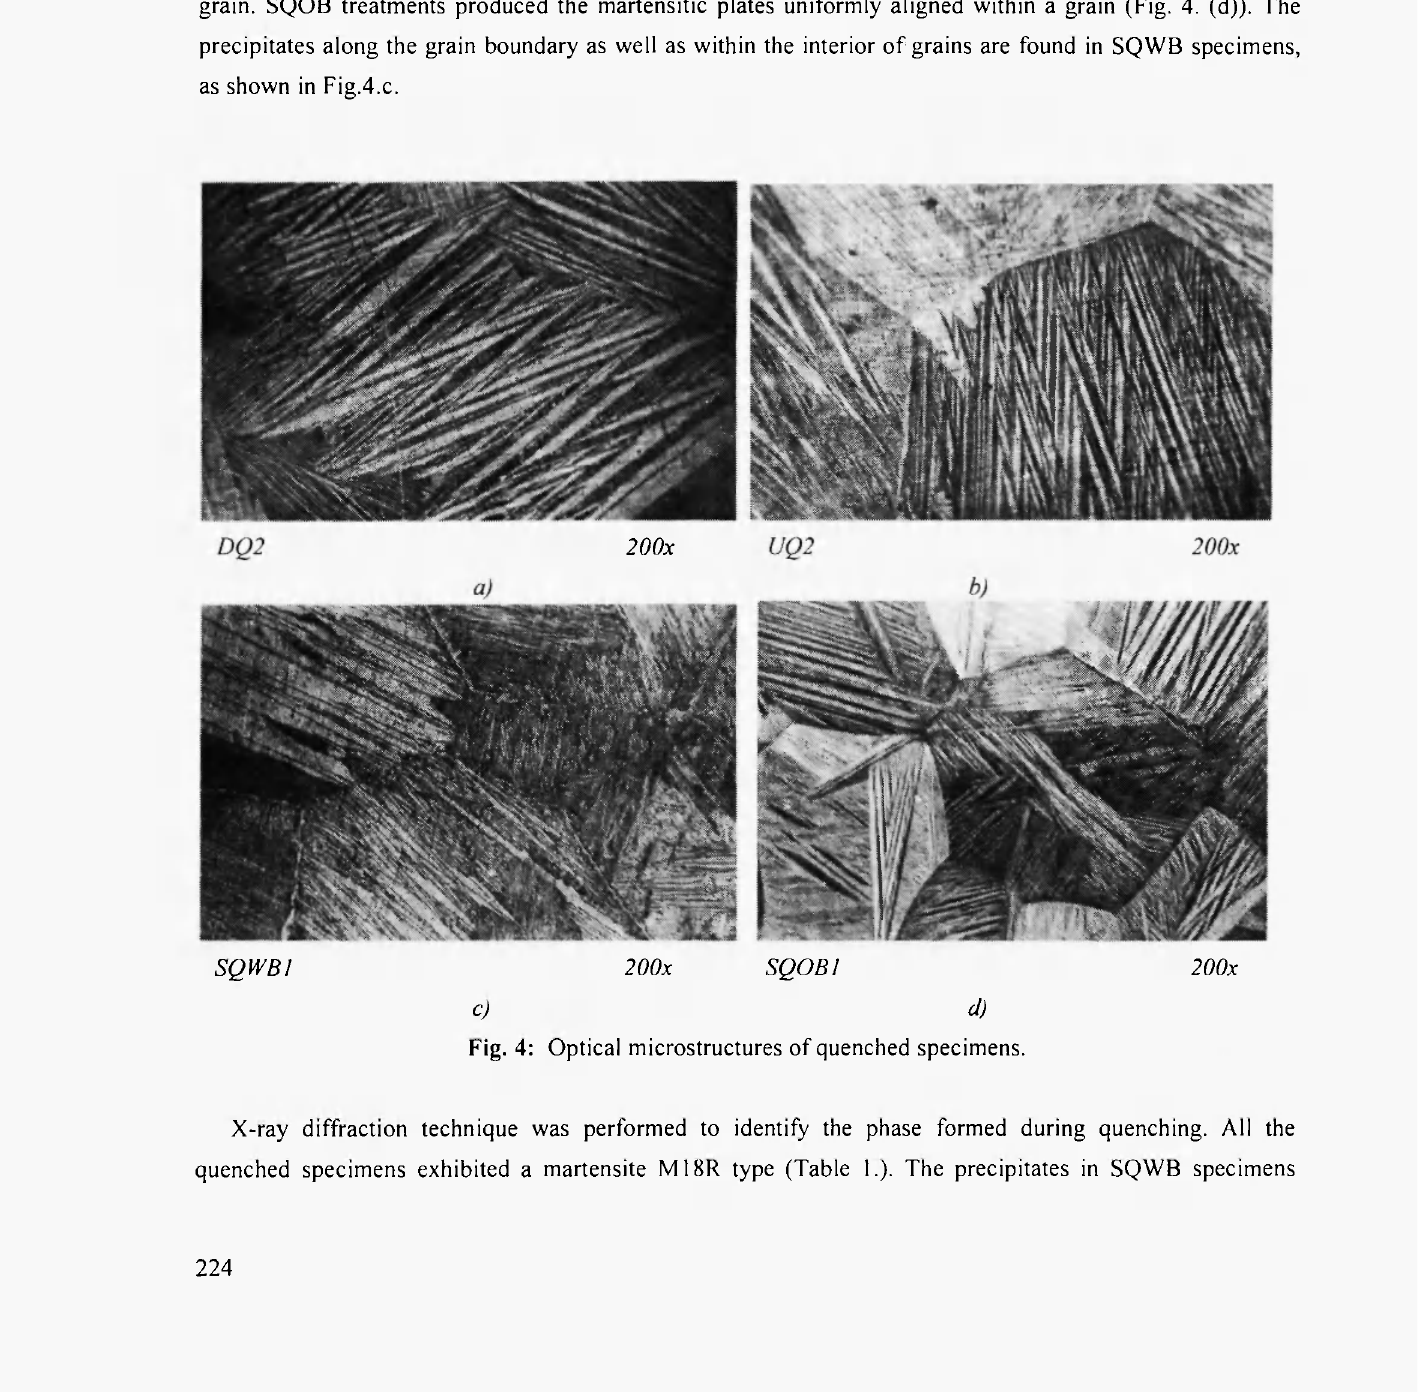
Fig. 4: Optical microstructures of quenched